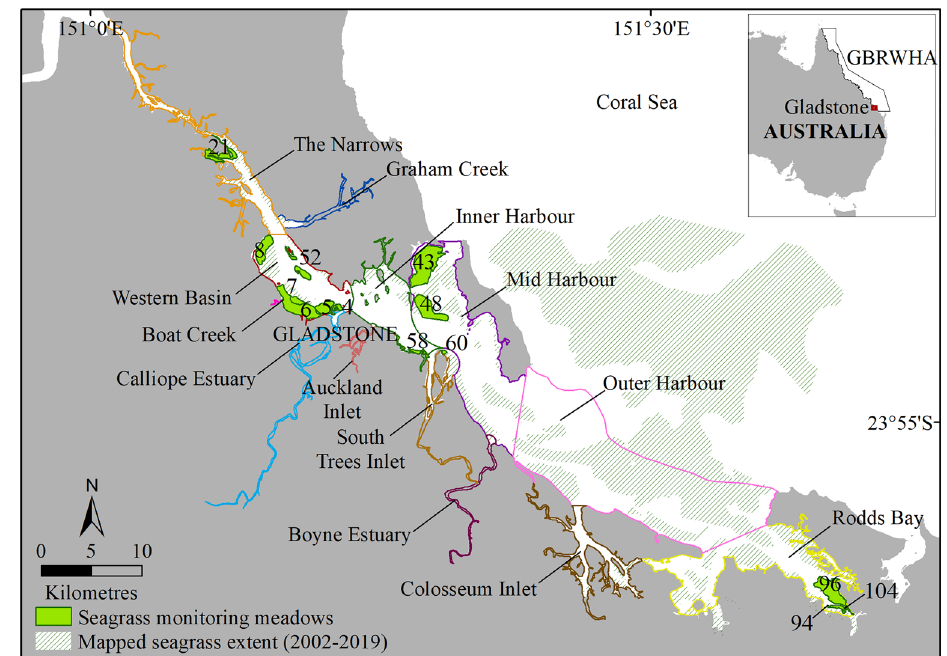
Figure 5. Gladstone Harbour with 13 Gladstone Healthy Harbour Partnership zones, 14 seagrass monitoring meadows surveyed in November 2019 (2020 GHHP reporting year), and composite of seagrass extent mapped approximately every 3–5 years between 2002 and 2019. Inset map: Survey area and Great Barrier Reef World Heritage Area (GBRWHA). Map created using ArcGIS software version 10.8 by Esri (www. esri.